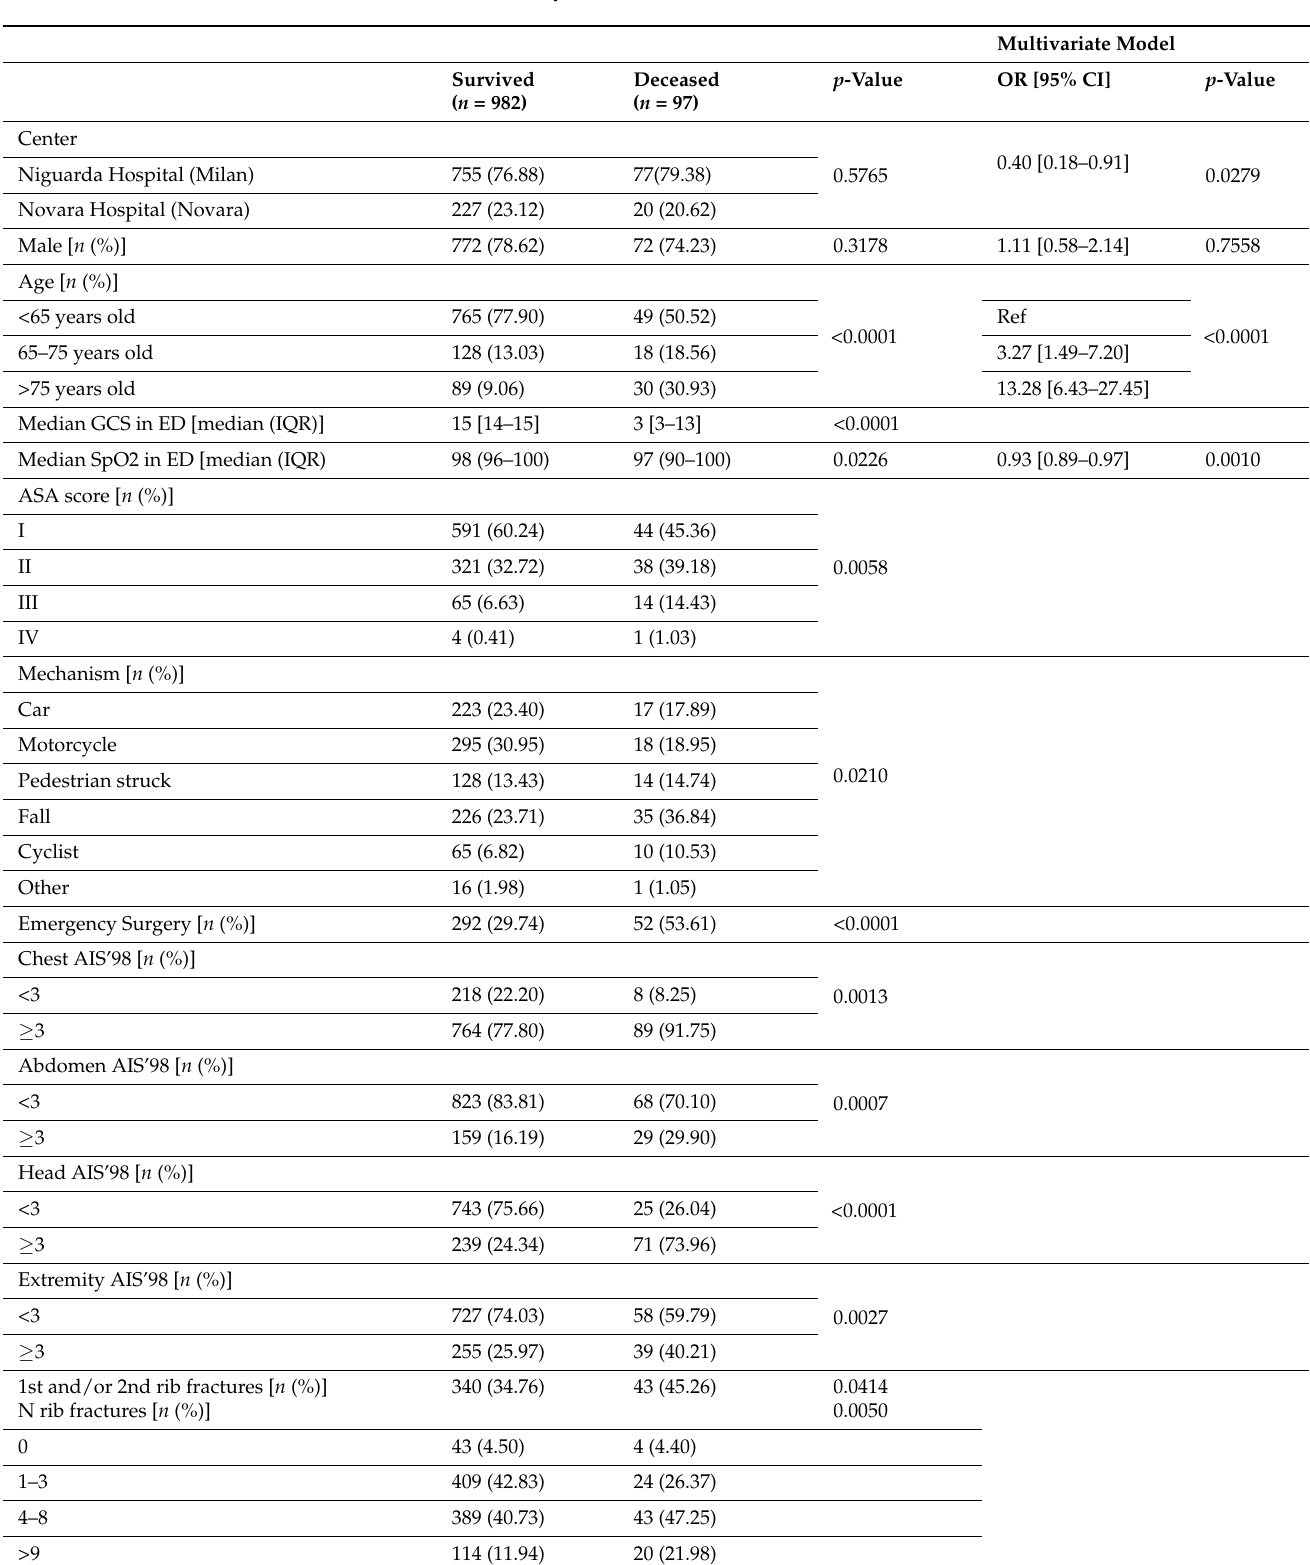
Table 4. Outcome